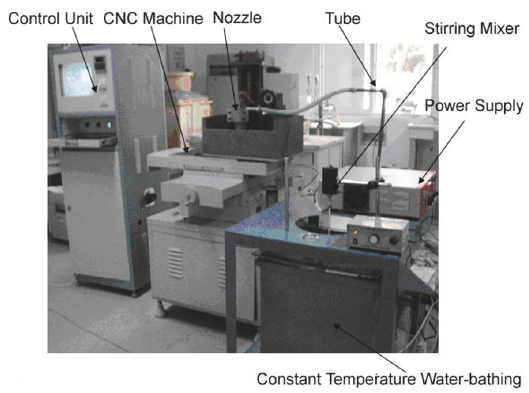
Figure 1: Experimental setup for nickel jet electrodeposition.